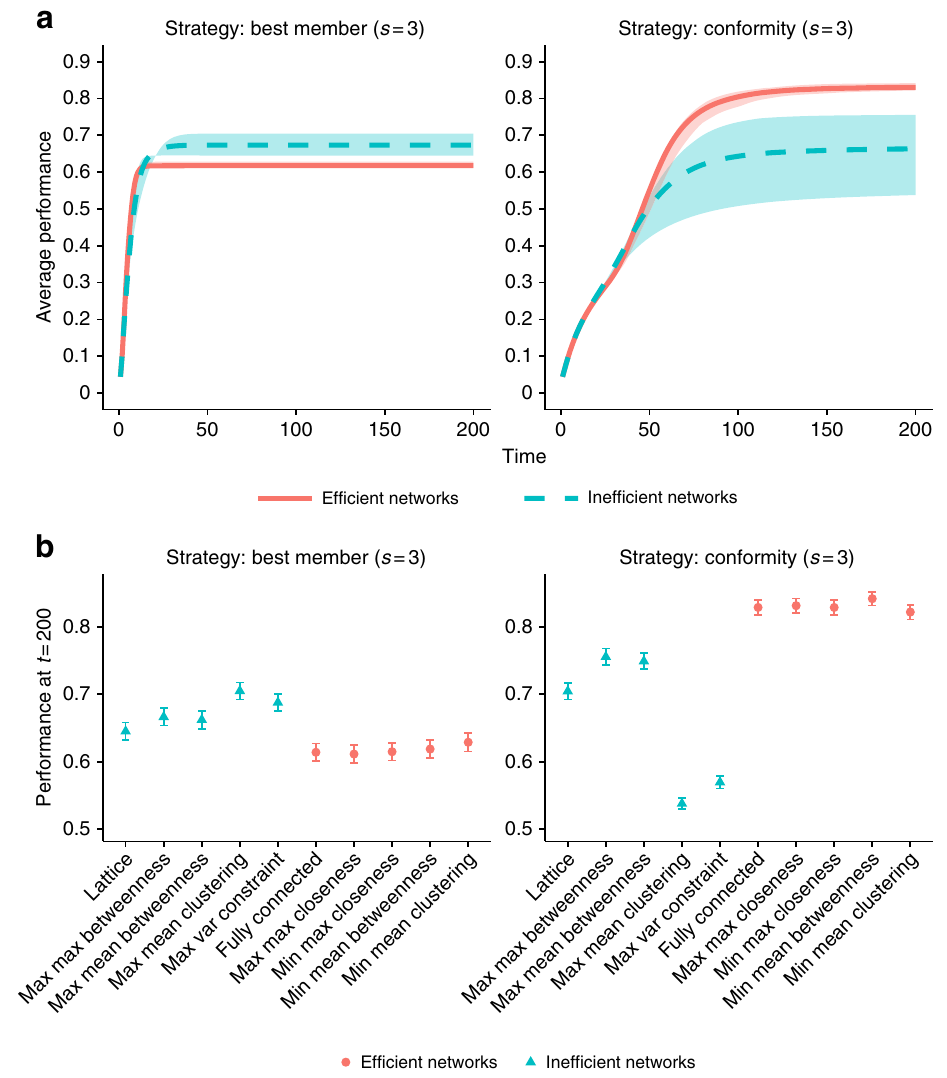
Figure 3 | Performance of different networks as a function of social learning strategy. ( a ) Group performance averaged across efficient (red solid lines) and inefficient (turquoise dashed lines) networks. Shadings around the lines show the region between the best and worst performing network in each category. ( b ) Average performance at the final time step ( t ¼ 200) for each network. Error bars show þ (cid:2) 2 s.e. of the mean. Left panels: individuals rely on the best member ( s ¼ 3) strategy; right panels: individuals rely on the conformity ( s ¼ 3) strategy. Inefficient networks outperform efficient networks when individuals rely on the best member strategy. Efficient networks outperform inefficient networks when individuals rely on the conformity strategy. Results in the left panel replicate the findings of Lazer and Friedman 15 while results in the right panel are in line with Mason and Watts 16 . Based on n ¼ 100 agents and 1,000